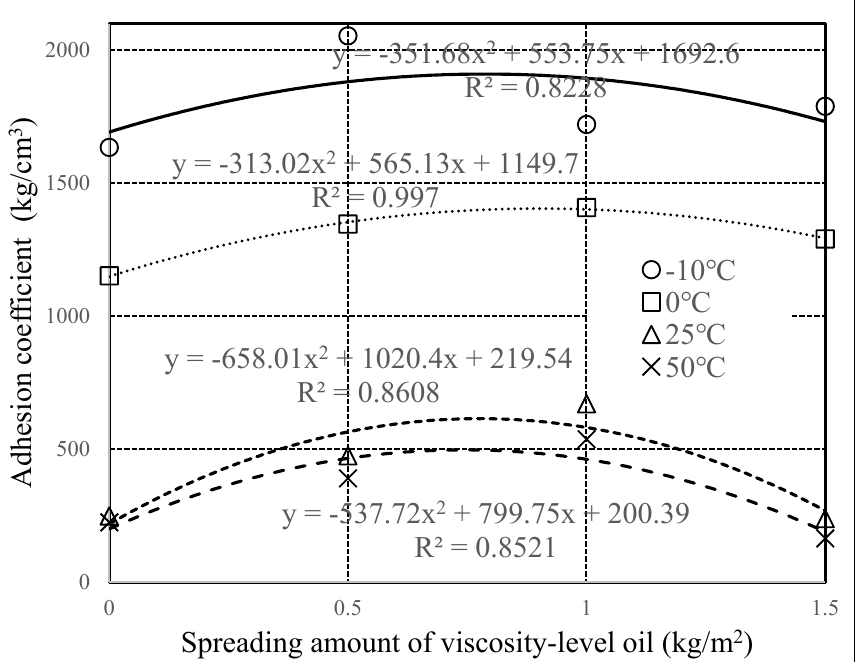
Figure 11. The curves relating spreading amount of viscosity-level oil A and adhesion coefficient.